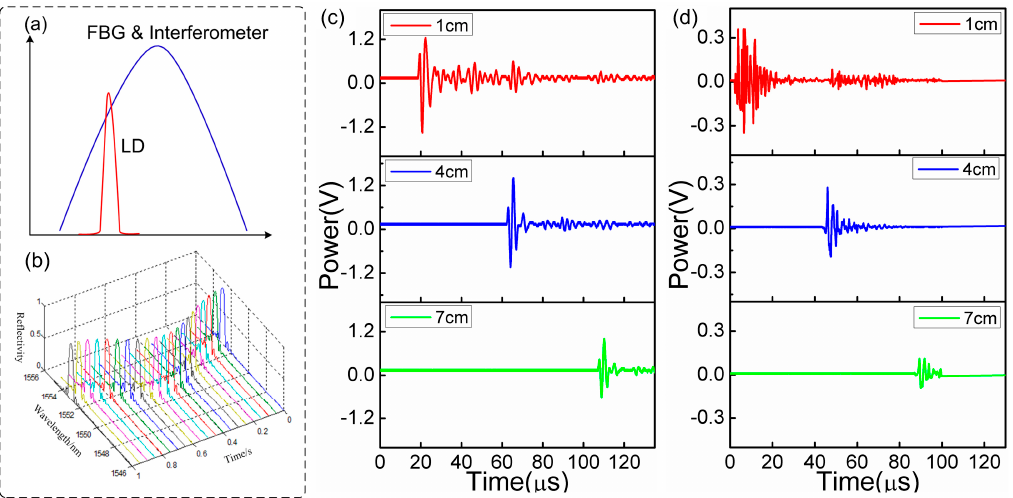
Figure 16. ( a ) Spectral side-band filtering mechanism; ( b ) FBG spectral response to ultrasonic; sensor’s responses to the pulse ultrasonic under the different distances and with different frequencies: ( c ) 300 kHz and ( d ) 1 MHz.